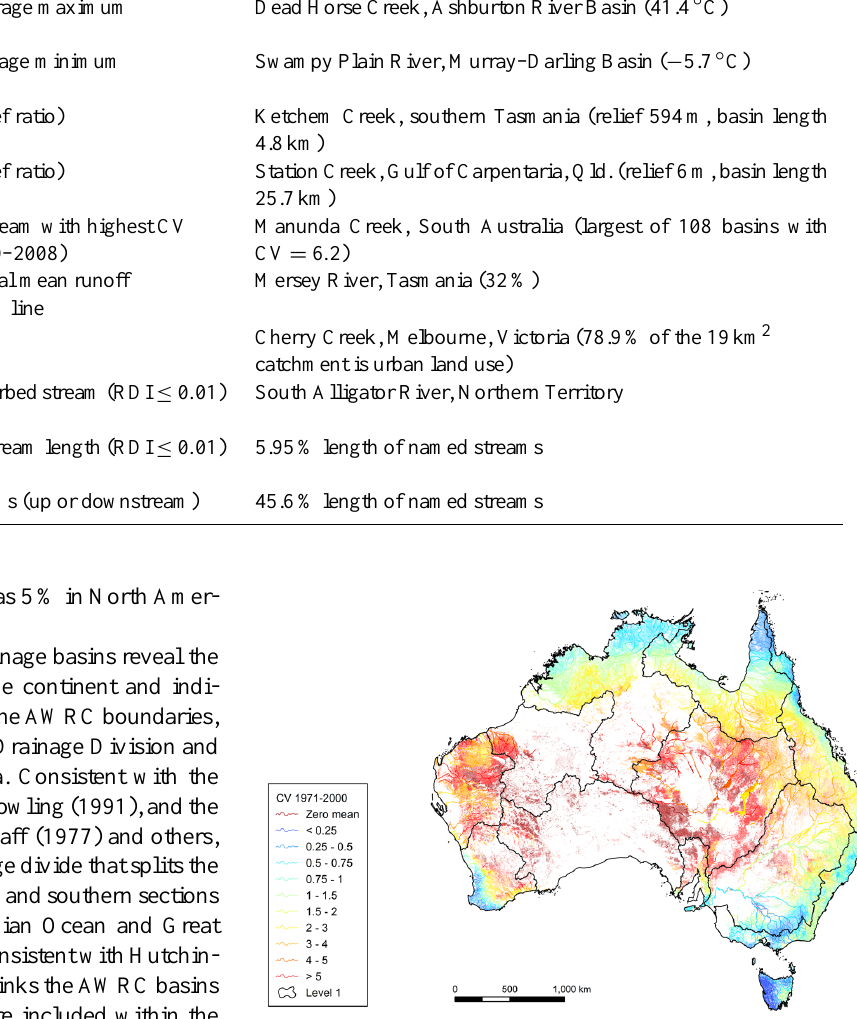
Figure 7. Interannual runoff variability: coefficient of variation of the annual totals of accumulated runoff volume for the period 1971 to 2000. Values extracted from the runoff lookup table described in Sect.